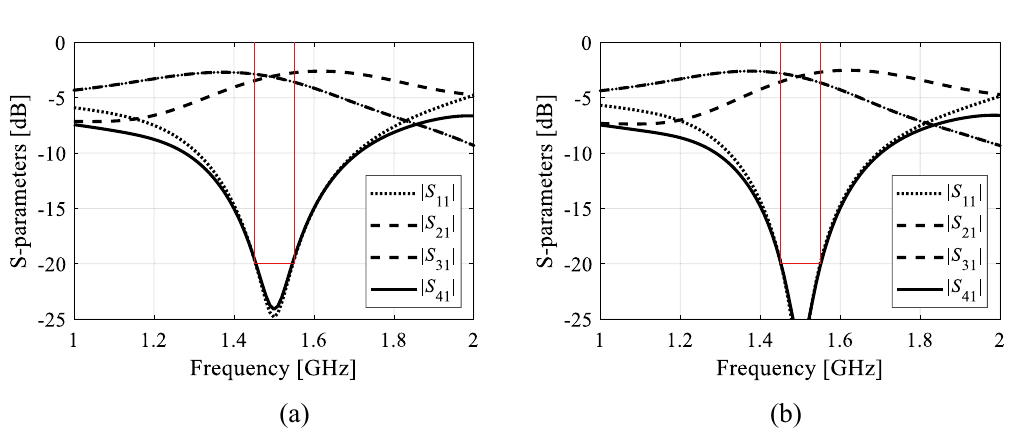
Figure 10. Circuit I: EM-simulated scattering parameters for two selected designs obtained using the proposed size reduction algorithm: ( a ) design 1 (footprint area 305.1 mm 2 ), ( b ) design 2 (footprint area 302.4 mm 2 ). Target operating frequency and bandwidth indicated using the vertical and horizontal lines, respectively.